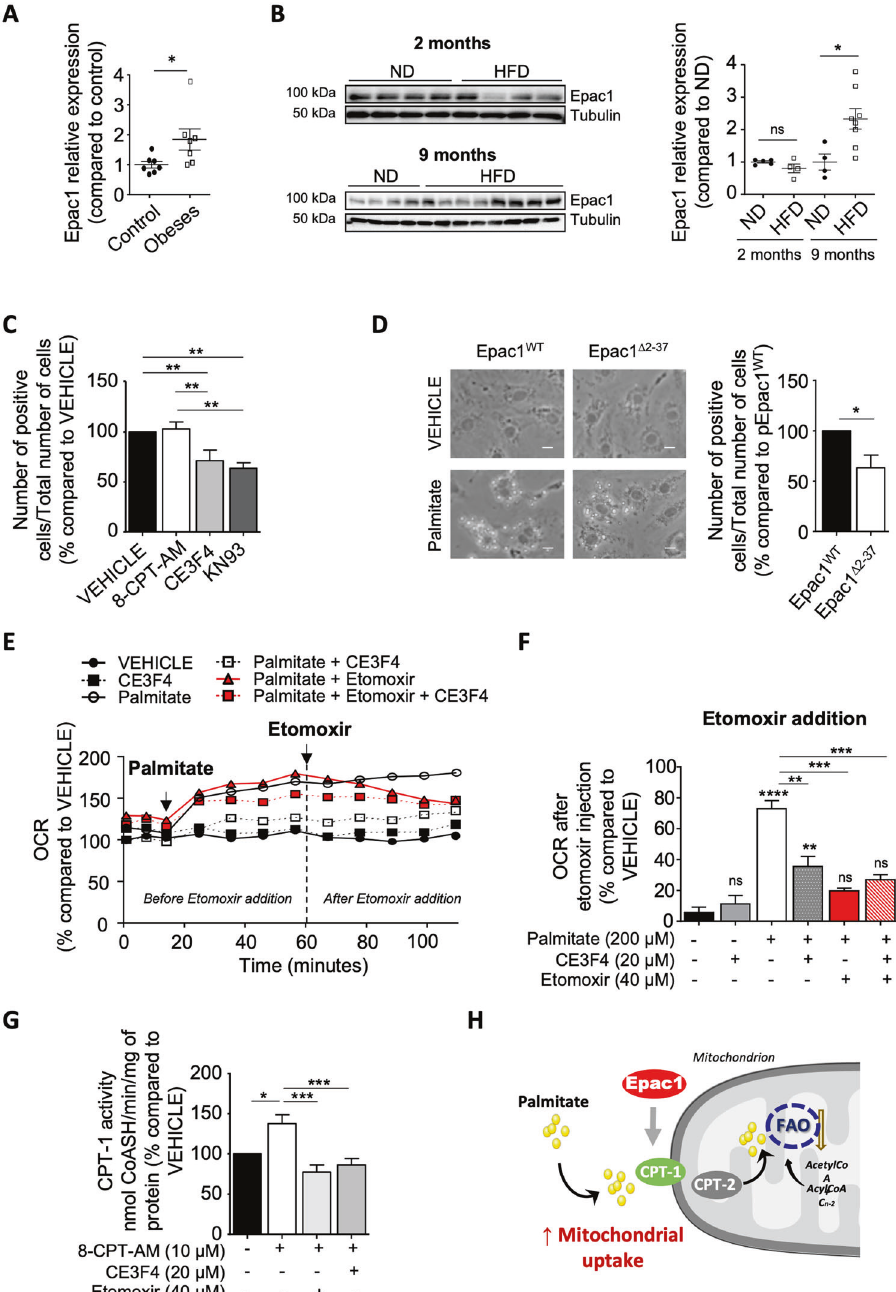
Fig. 3 Epac1 promotes lipid accumulation and regulates mitochondrial FA uptake. A, B Representative immunoblot and quanti fi cation of Epac1 protein in human right atrial appendage tissues from non-obese control or obese patients ( n = 7), and in cardiac samples from C57Bl6 mice subjected to normal diet (ND) or high-fat diet (HFD) for 2 or 9 months ( n = 5 – 8). GAPDH, Tubulin, loading control. C, D Quanti fi cation of lipid accumulation ( C ) in primary cardiomyocytes pretreated or not (VEHICLE) with 8-CPT-AM (10 μ M, 30 min), CE3F4 (20 μ M, 30 min), or KN-93 (5 μ M, 30 min) and incubated with palmitate (500 μ M, 24 h) ( n = 4 – 6 different experiments) Scale, 10 μ m. In D cells were transfected with the indicated plasmids for 24 h and then incubated with palmitate (500 μ M, 24 h) ( n = 5 different experiments). Representatives images are shown on the left panel. E, F Measurement of OCR in cardiomyocytes pretreated with CE3F4 (20 μ M, 30 min) or not (VEHICLE) after acute treatment of palmitate (500 µM, 15 min) and CPT-1 inhibitor, etomoxir (40 μ M, 60 min) ( n = 2 – 4). In F the graphical representation is shown ( n = 2 – 4). G CPT-1 activity in cardiomyocytes pretreated or not with 8-CPT-AM (10 μ M, 30 min) and then treated with CE3F4 (20 μ M, 30 min) or etomoxir (40 µM, 30 min) ( n = 6 – 8). H Schematic representation of the regulation of CPT-1 activity by Epac1. The results are expressed as mean ±SEM and were analyzed with a two-way ANOVA/Bonferroni post test. In A , a Mann – Whitney test was performed. * p < 0.05, ** p < 0.01, *** p < 0.001, **** p < 0.0001 vs indicated value. ns not signi fi cant.